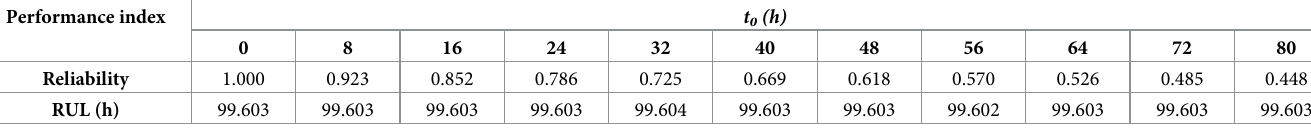
Table 6. RUL values during 80 operational hours of the excavator in the classical-exponential model. Performance